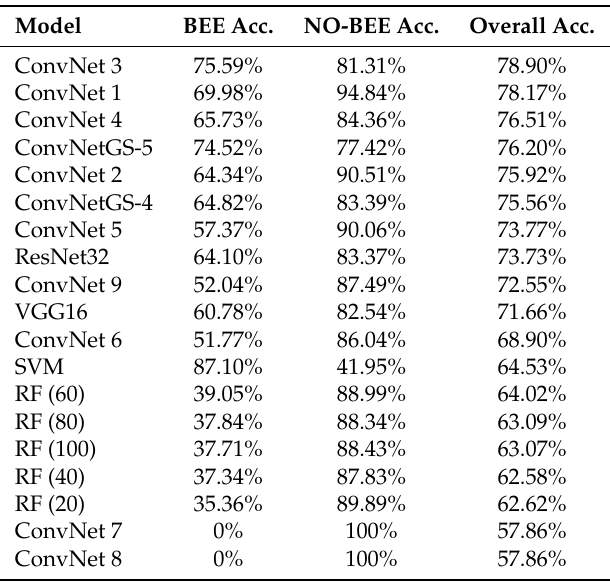
Table 7. Model performance on BEE2_2S validation dataset; all ConvNets, ResNet32, and VGG16 were trained for 100 epochs each. The two top performing auto-designed ConvNets (ConvNetGS-5 and ConvNetGS-4) are included for comparison. The overall accuracy is sorted from highest to